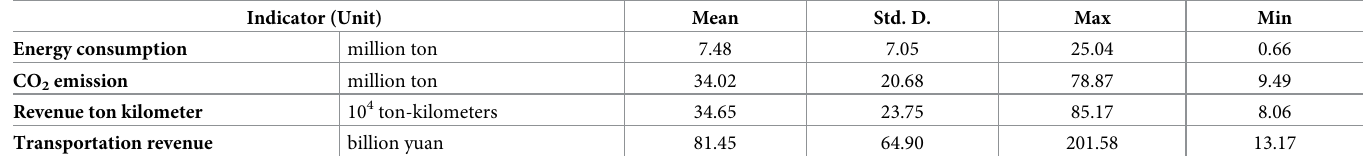
Table 3. Statistical descriptions of the different civil aviation variables. Indicator (Unit)